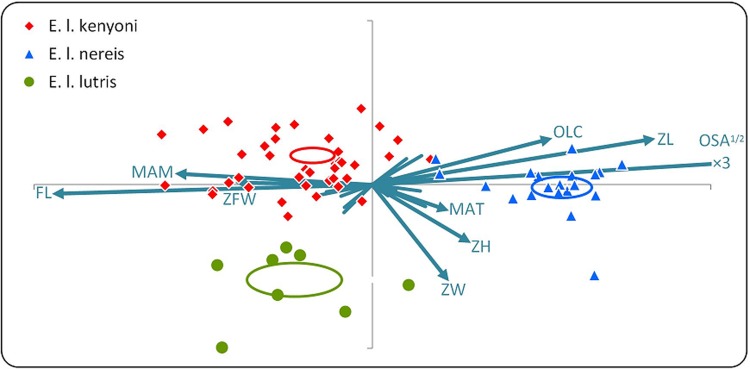
Canonical ordination of sea otter (E. lutris) skull form by subspecies.Symbols reflect feeding mode, which varies from relative piscivory (circles) to greater inclusion of invertebrates (diamonds), to durophagy (triangles). Vectors give covariance structure coefficients and only major vectors are labeled (trait abbreviations as in Table 1). The vector for OSA½ proceeds approximately three-fold more than shown. Ellipses depict 95% confidence intervals for subspecies centroids. The horizontal axis generally reflects the classic morphological suite of traits for durophagy: individuals to the right in this space have greatly increased occlusal surface area, long zygomas, short outlever at the level of the carnassials, short faces, a relatively short moment arm of the masseter, and relatively narrow zygomatic fossa in the center of the fossa. Plot aspect ratio (1.4:1) reflects the square root of the eigenvalue ratio for the major (horizontal) and minor (vertical) axes of skull form.